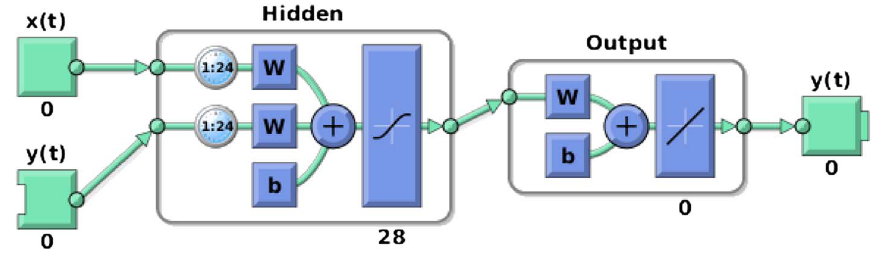
Fig. 2. MLP Architecture. Image credit: Mathworks MATLAB R2014b (MATLAB, 2014).